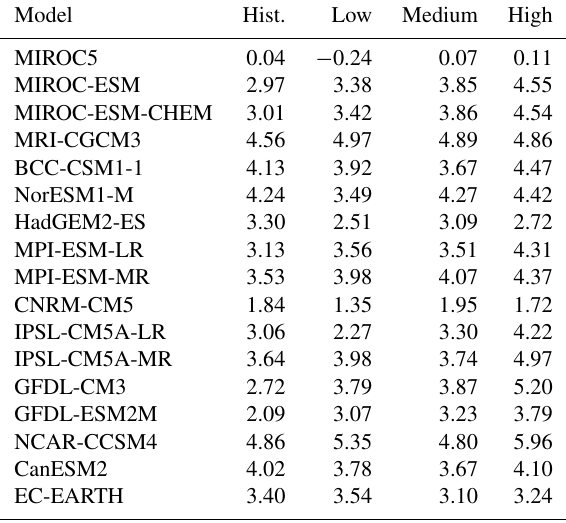
Table A1. Twenty-year means of zonal geostrophic wind (me- tres per second) at 55 ◦ N, 15 ◦ E, according to CMIP5 model results: historical (1986–2005) and future (2081–2100) under low-emission (RCP2.6), medium-emission (RCP4.5), and high- emission (RCP8.5)